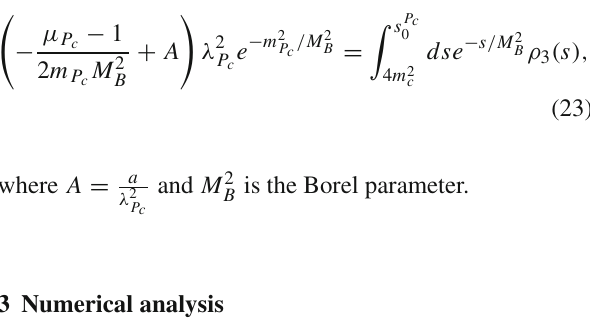
Table 1 Some input parameters needed in the calculations Parameter